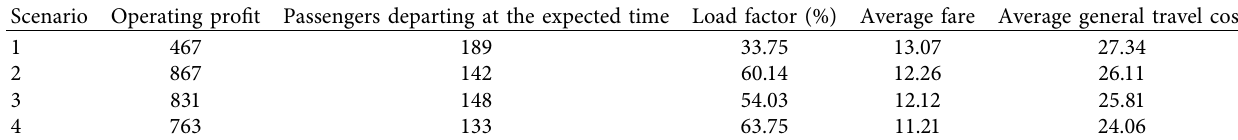
Table 5: Scenario comparison for the case study of Beijing.